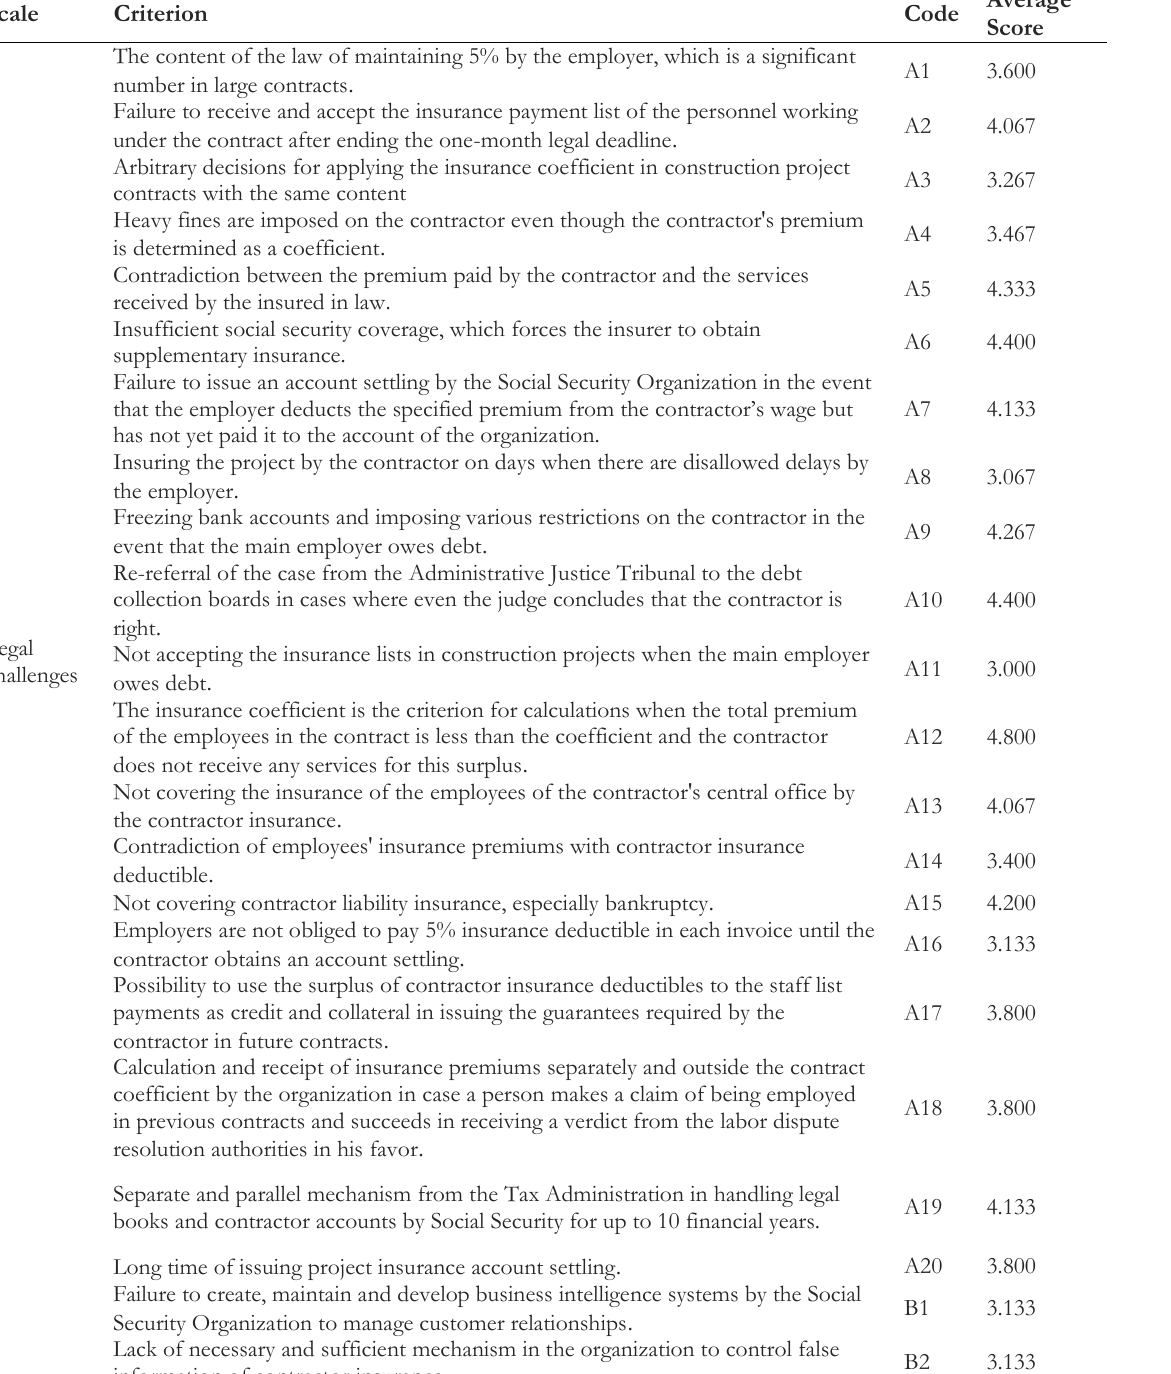
Table 3. Introducing the research